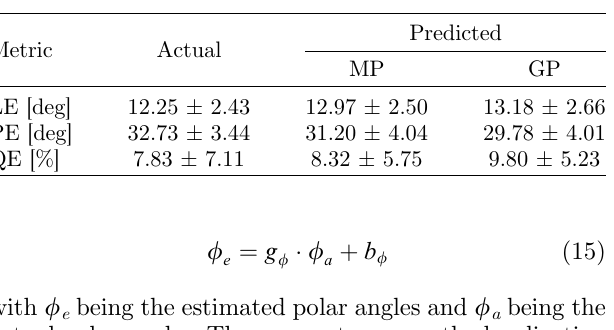
Table 2. Predicted performance metrics averaged across all subjects and directions (±1 standard deviation across subjects) for both model variants. Actual data from